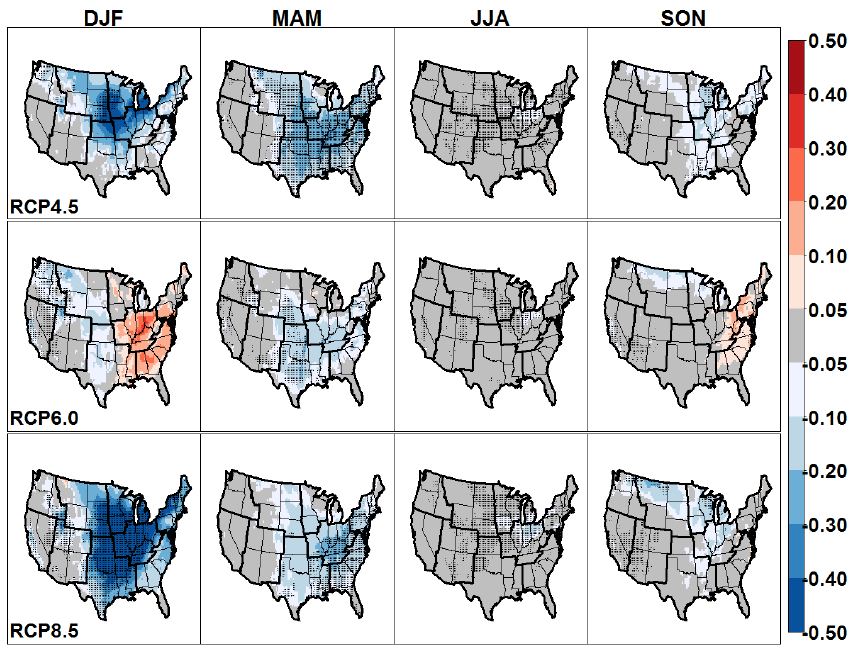
Figure 8. Changes in seasonal mean concentrations (µgm − 3 ) of PM 2 . 5 nitrate under three RCP scenarios. Dark pixels indicate where differences are significant according to Student’s t test ( p < 0 . 05).